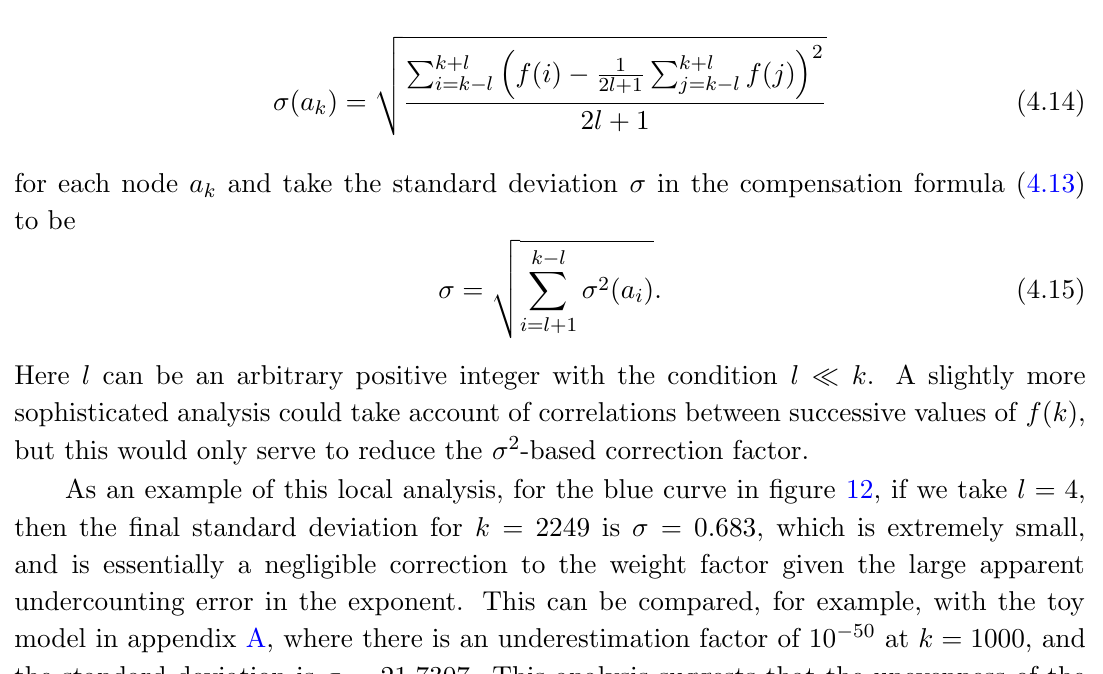
Figure 12 . The plot of log random blow up sequences, whose end points are bases with h 1 ; 1 ( B ) =